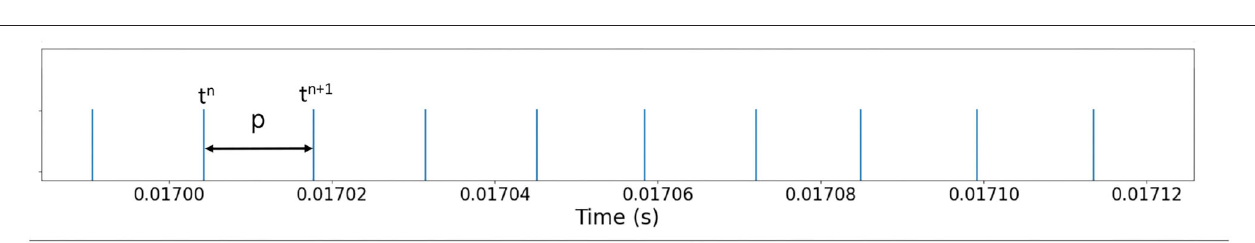
FIGURE 2 | Neuron circuit spike response. Since spike waveform is not needed for the filtering process, spike events are registered as a list of times when the neuron circuit reach threshold voltage. Time elapsed between t n and t n + 1 is denoted as p